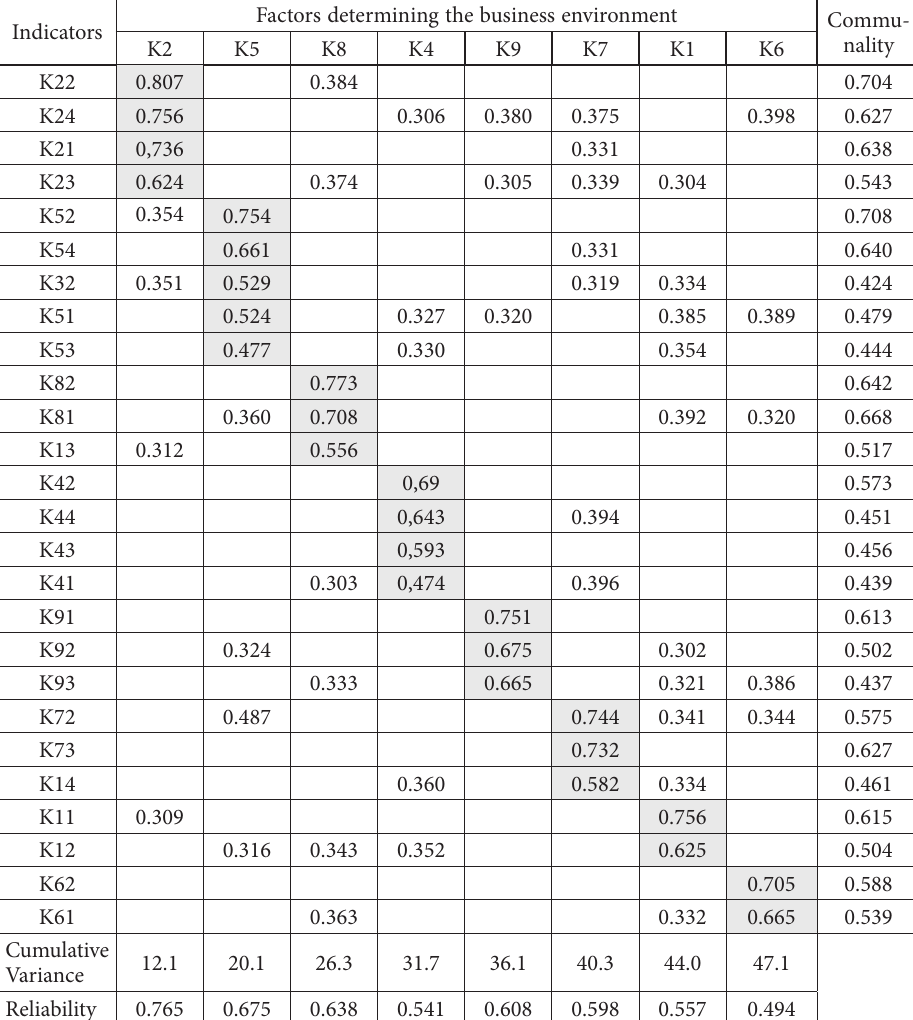
Table 2. Results of factor load on indicators, reliability and communality (source: own processing) Factors determining the business Indi cators